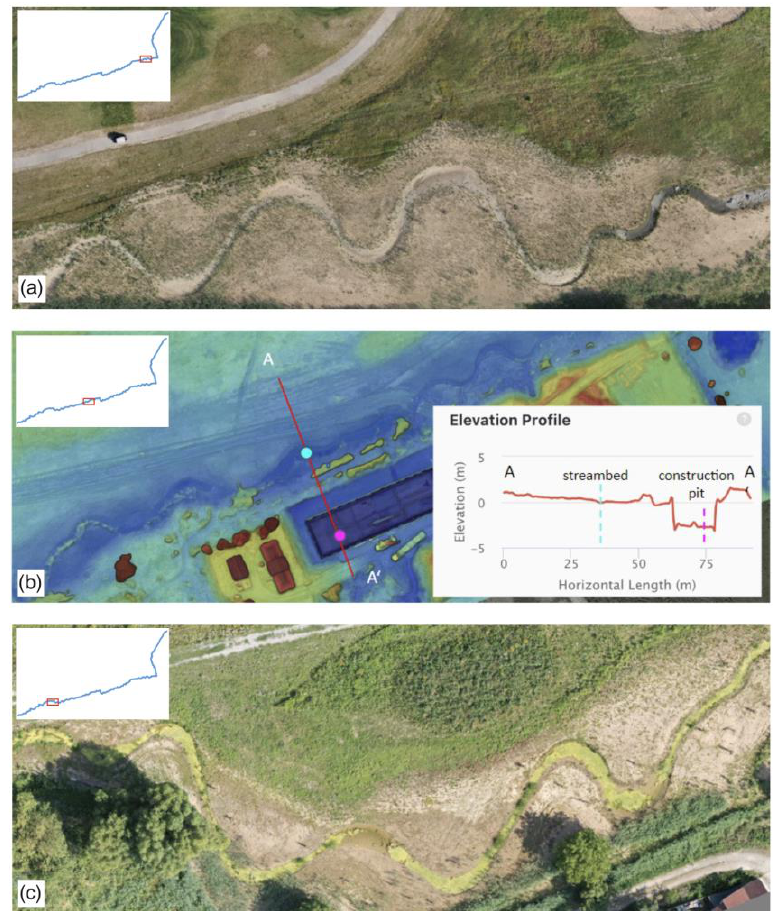
Figure 9. UAV-assisted detection of the qualitative issues in hydrological processes in the LIP brook. ( a ) Drying of the channel in the summer season, ( b ) 3D model of the construction pit along the restored stream, and ( c ) in-stream eutrophication developed after the project termination in July 2019.